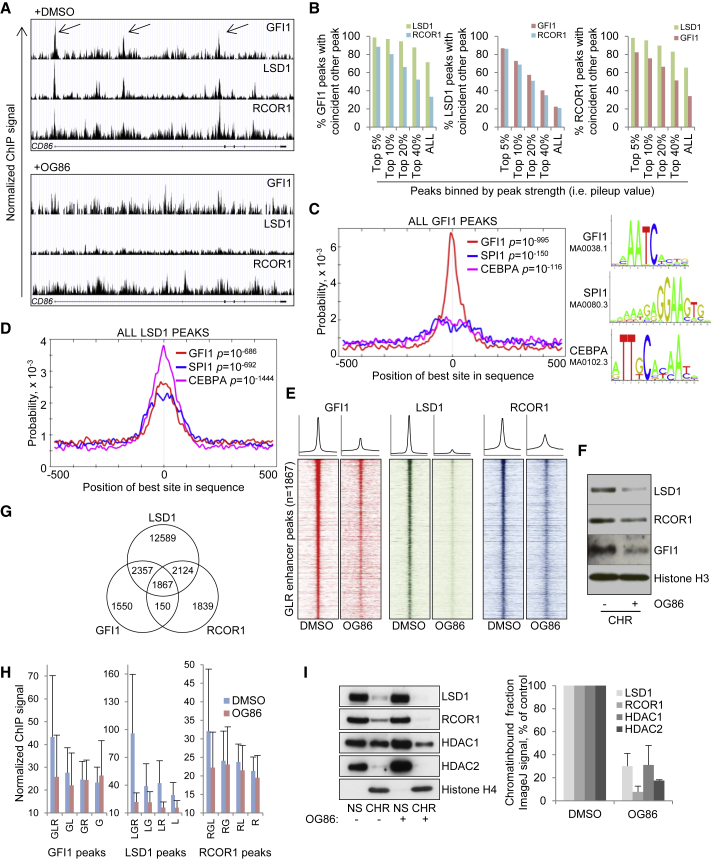
Close Physical Association of GFI1, LSD1, and RCOR1 on Chromatin and Its Abrogation by OG86(A) Exemplar ChIP-seq tracks following treatment of THP1 AML cells with DMSO vehicle or 250 nM OG86 for 48 hr. Arrows indicate coincident GLR peaks.(B) Bar graphs show the percentage of GFI1 (left), LSD1 (middle), or RCOR1 (right) binding peaks with the indicated coincident binding peaks.(C and D) MEME-ChIP motif enrichment plots with indicative p values for (C) GFI1 peaks (n = 5,924) or (D) LSD1 peaks (n = 18,937).(E) Heatmaps show ChIP signal for the indicated proteins at 1,867 “GLR” peaks (peak apex ± 1 kb) ranked according to GFI1 peak strength.(F) Western blot shows the indicated chromatin-bound proteins in THP1 AML cells treated with DMSO vehicle or 250 nM OG86 for 48 hr. CHR, chromatin.(G) Venn diagram shows categories of binding peaks in THP1 AML cells.(H) Bar graph indicates means ± SD for ChIP signal at sites of the indicated proteins and the indicated peak categories in DMSO vehicle-treated cells and at the same sites in OG86-treated cells after 48 hr. G, GFI1; L, LSD1; R, RCOR1.(I) Murine MLL-AF9 AML cells were treated with 250 nM OG86 or DMSO vehicle for 48 hr followed by subcellular fractionation. Representative western blots (left) show the presence of the indicated proteins in the indicated cellular fractions in the presence or absence of OG86. The graph on the right shows means ± SEM for western blot signal in chromatin-bound fractions in the presence or absence of OG86, as determined by ImageJ densitometry (n = 3). NS, nuclear soluble; CHR, chromatin.See also Figure S3.